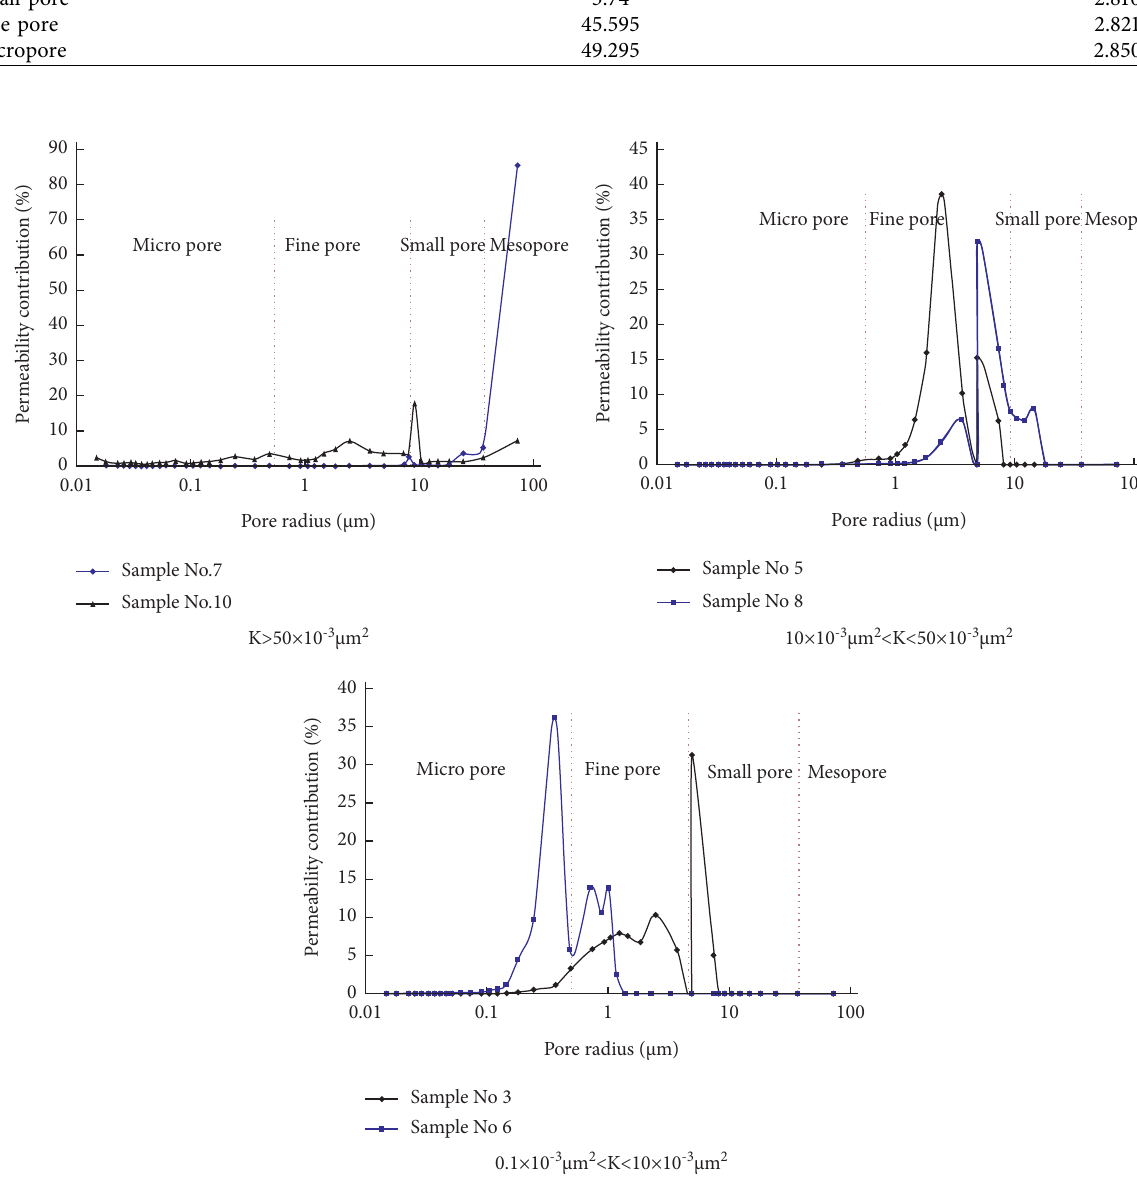
Figure 3: The permeability contribution of different